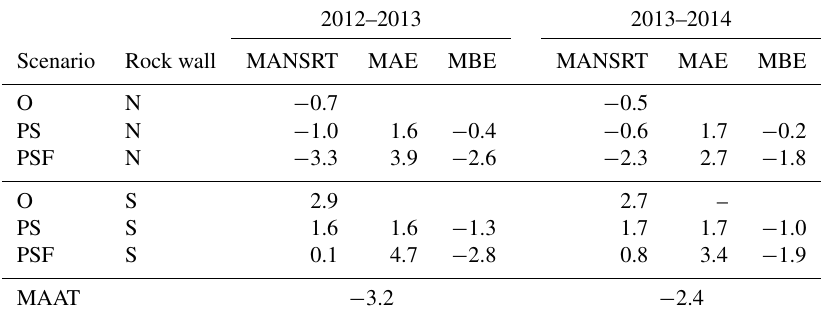
Figure 8. Two-year data showing the relation between measured and modelled NSRT data for both (a, d) snow-covered and (b, e) forced snow-free scenarios, as well as for (c, f) generally snow-free NSRT locations. The mean annual r 2 as well as the linear relation between measured and modelled NSRT data are shown. Table 3. MANSRT, MAE and MBE (all in ◦ C) calculated within the individual N- and S-facing rock walls at NSRT locations. The MAE and MBE were calculated between measurements (O) and model predictions of both the snow-covered (PS) and the snow-free scenarios (PSF) at NSRT locations. Additionally, mean annual air temperature (MAAT) for the years 2012–2013 and 2013–2014 is